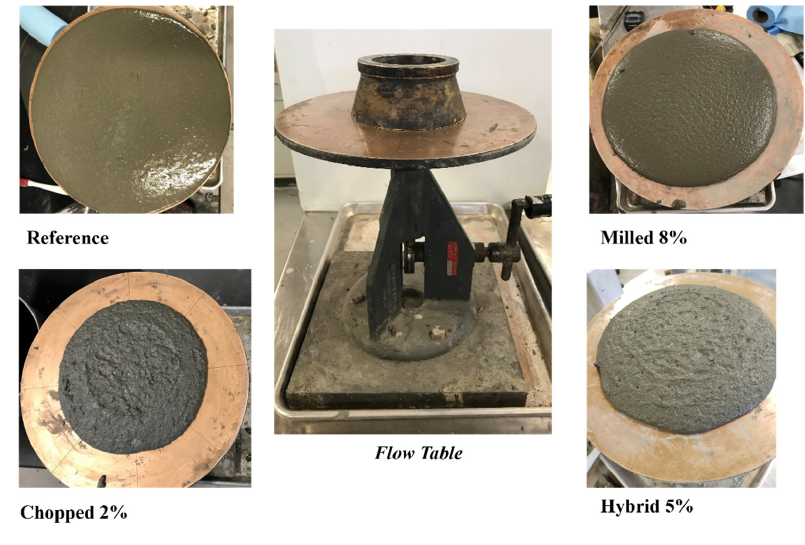
Figure 5. Sample of flow table testing and measurements.